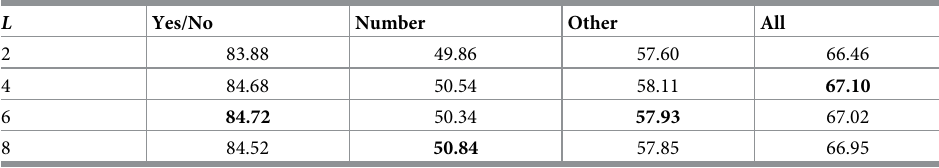
Table 2. The performance of different layers of encoder and